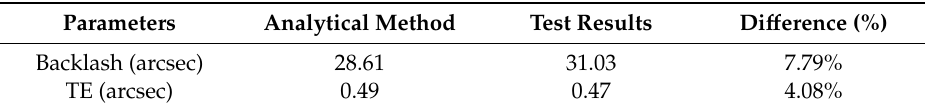
Table 5. Percentage di ff erences of analytical method relative to test results of backlash and TE caused by tooth profile modification (TPM) and